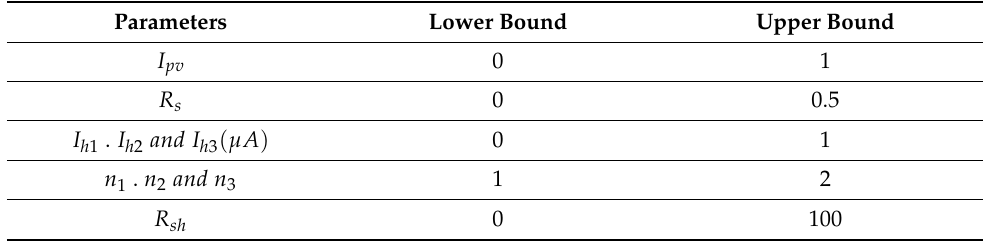
Table 1. The lower and upper bounds of the variables.